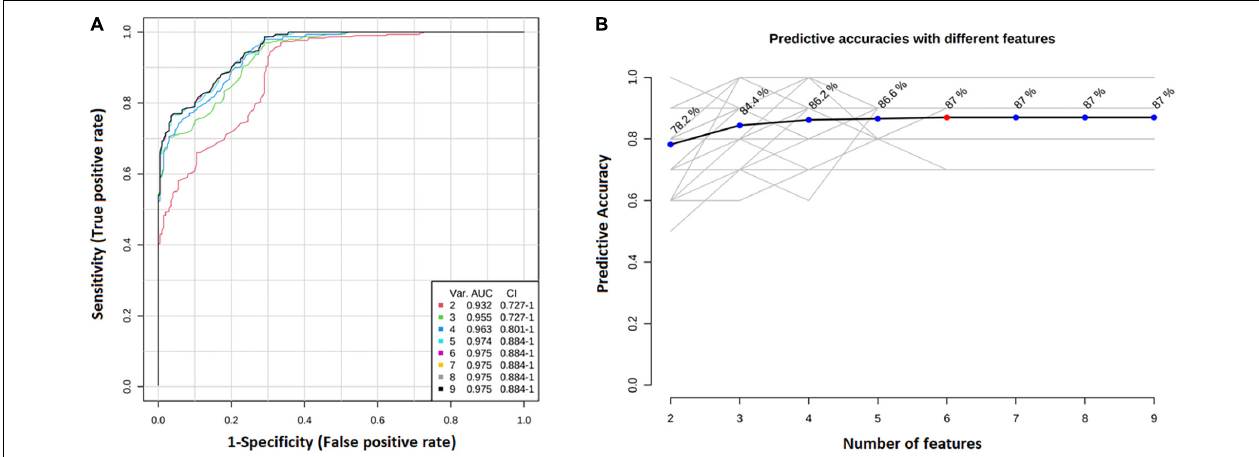
FIGURE 6 | Diagnosis predictive model with all metabolites via logistic regression analysis. (A) ROC curve for building a diagnostic and predictive model with all metabolites via logistic regression analysis. Area Under the Receiver Operating Characteristics (AUROC) was performed on a multivariate algorithm partial least squares-discriminant analysis (PLS-DA). It used the classification method PLS-DA built-in for calculating accuracy, sensitivity, and specificity. The sensitivity and specificity were summarized using the area under the curve (AUC); (B) The best predictive accuracy was